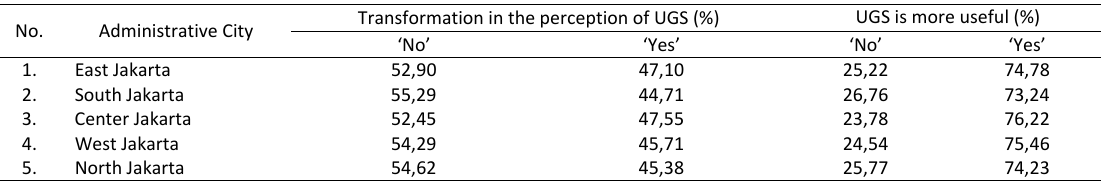
Table 3: Respondents' perceptions of UGS during the COVID‐19 pandemic